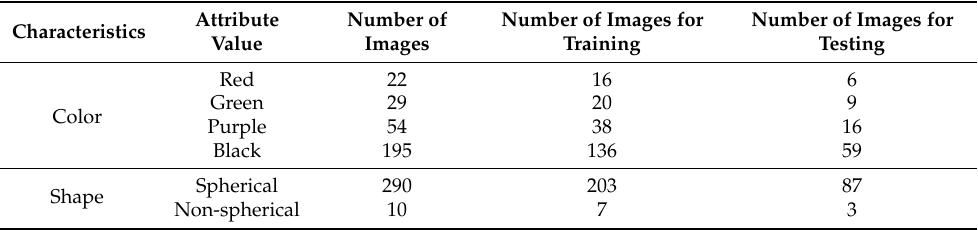
Table 1. Distribution of grape characteristics in dataset.